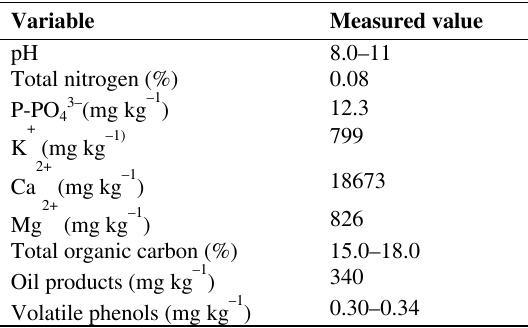
Table 1. Chemical properties of semi-coke from the control plot